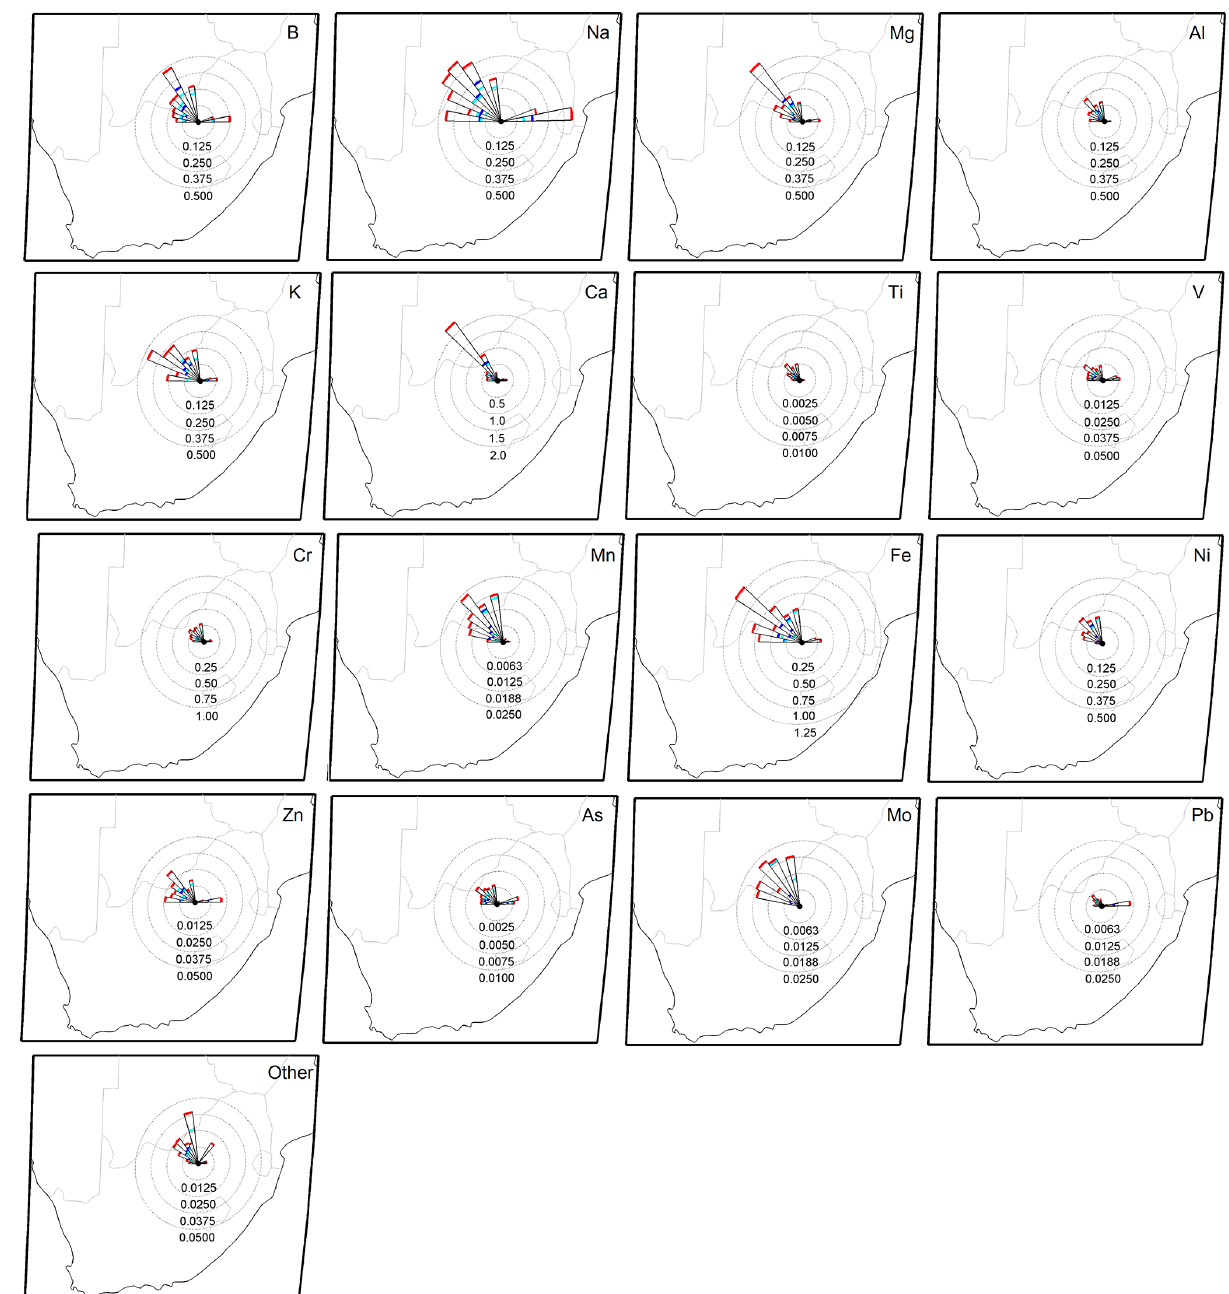
Figure 7. Pollution roses of trace metal species that were 25% or more of the time detected with the analytical technique.